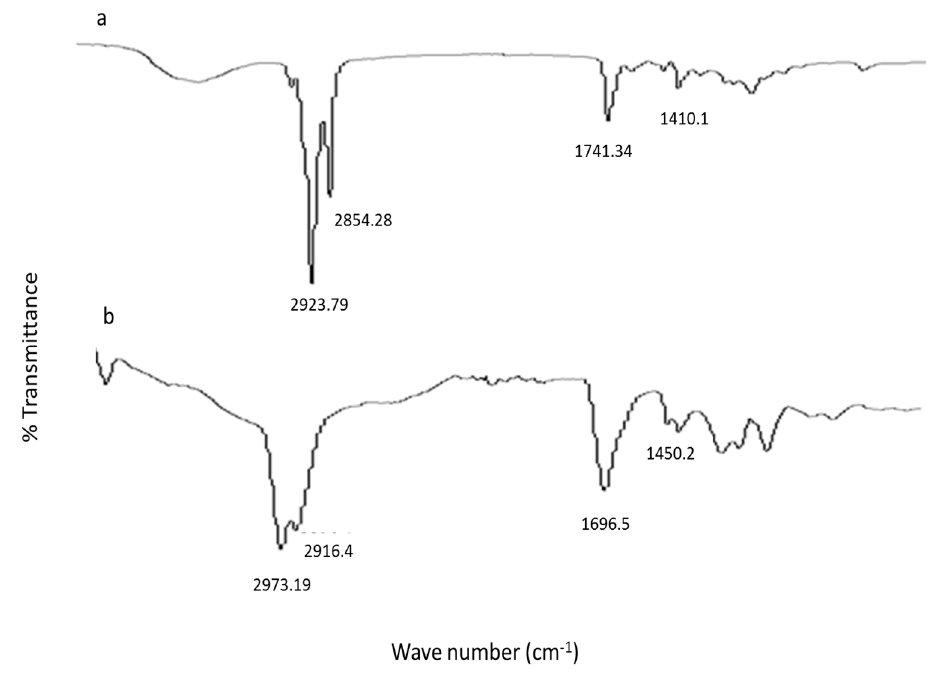
Figure 7. ( a ) FTIR Spectra of unloaded and ( b ) capsaicin loaded nanocrystal formulation.